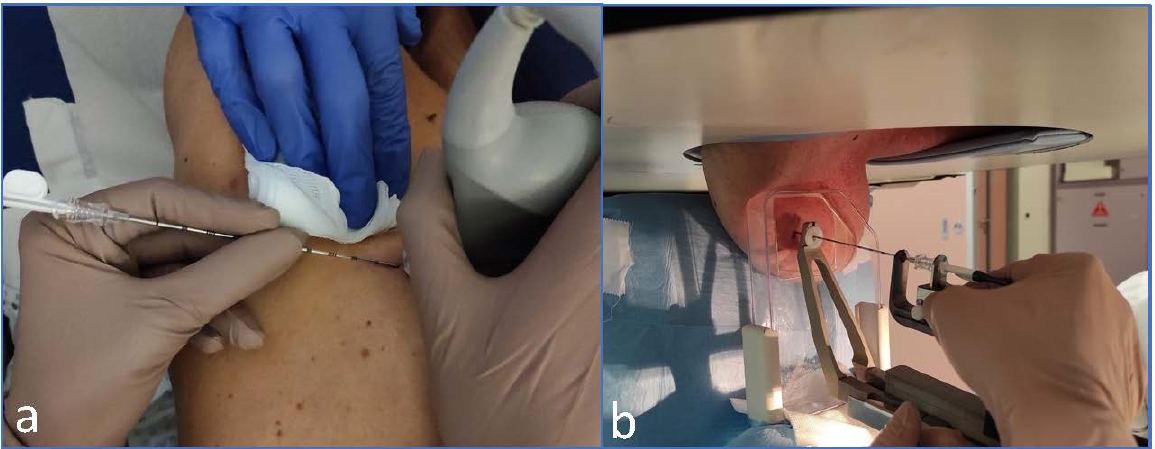
3 Figure 1. The 18-gauge Magseed